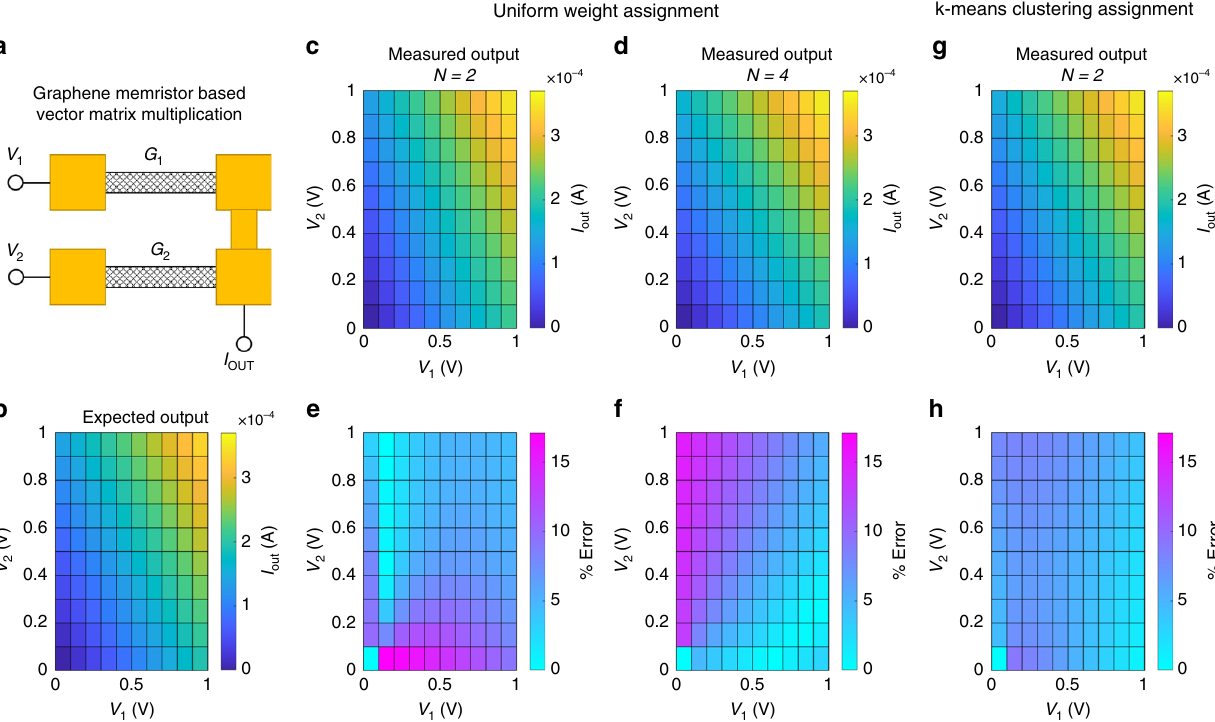
Fig. 4 Graphene memristor based vector-matrix multiplication (VMM) using k -means clustering. a Memory architecture for executing VMM operations. Drain voltages ( V 1 and V 2 ) are used as the input vector and graphene memristor conductance values ( G 1 and G 2 ) are used as the weight matrix. The output current ( I OUT ) is used as the output vector. b Colormap of the expected output current corresponding to different input voltage vectors for G 1 = 215 µ S and G 2 = 155 µ S. Experimentally obtained output currents when these weights are rounded to the nearest conductance states offered by the respective graphene memristors with uniformly distributed memory levels for ( c ) N = 2 and ( d ) N = 4. Error between the expected and actual output current for ( e ) N = 2 and ( f ) N = 4. g Experimentally obtained output current and ( h ) error when the weights are rounded to the nearest conductance states following k -means